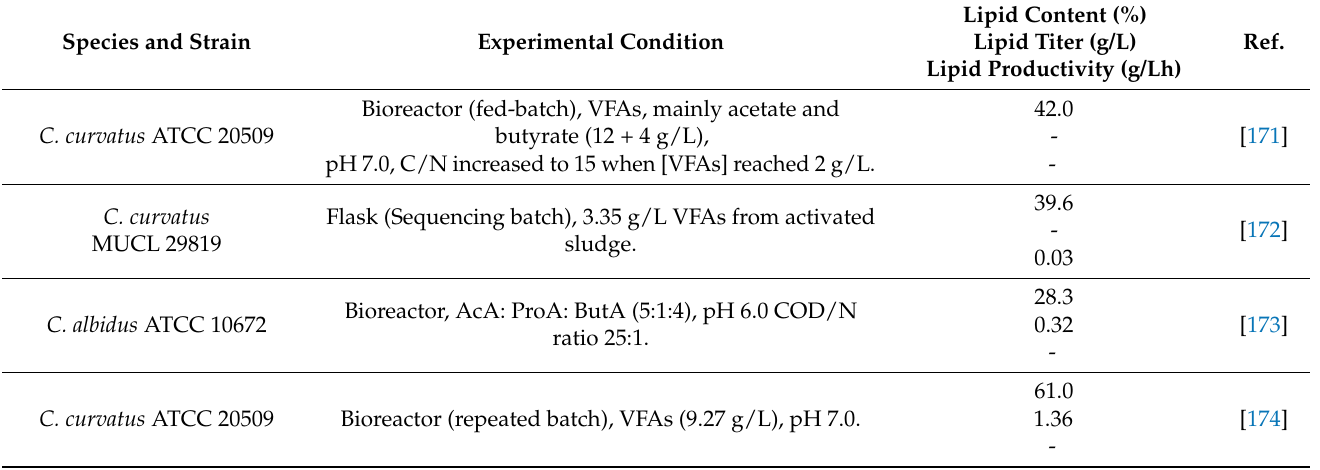
Table 5. Lipid production by oleaginous yeasts ( Cryptococcus albidus , Cryptococcus curvatus , and Yarrowia lipolytica ) using a mixture of VFAs as carbon source. The experimental conditions column also contains information on the culture method used: flasks, two-stage batch, sequential batch and